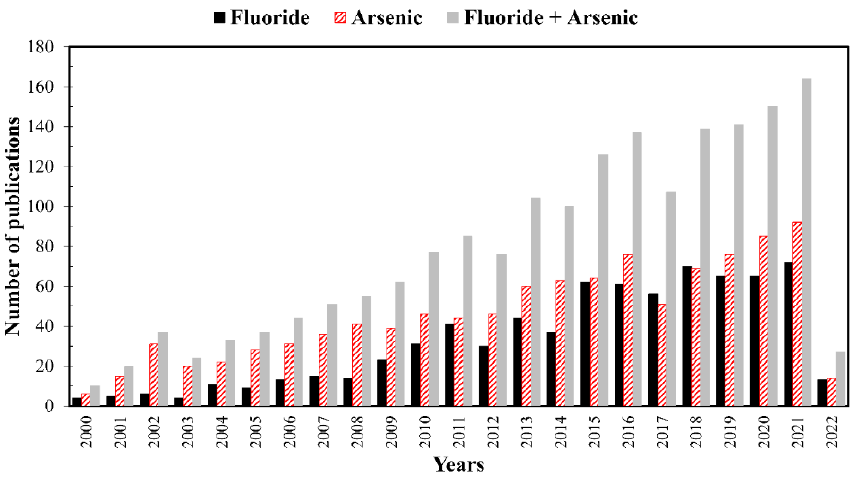
Figure 1. Number of publications per year from 2000 to 2022 searching on Scopus ® : “fluoride AND adsorption AND drinking water”, “arsenic AND adsorption AND drinking water”. “Fluorine + arsenic” is the sum of the papers relating to fluoride and the papers relating to arsenic.